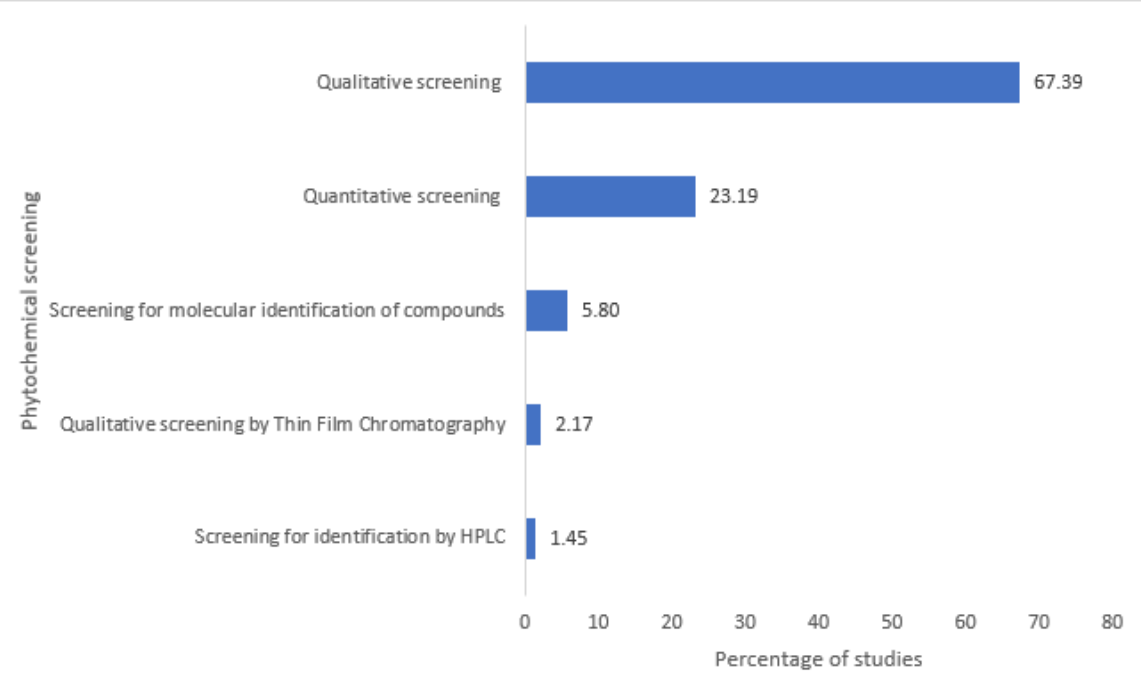
Table 2 . Methodologies of studies of toxicity tests: limitations and proposals for improvement of research practice .